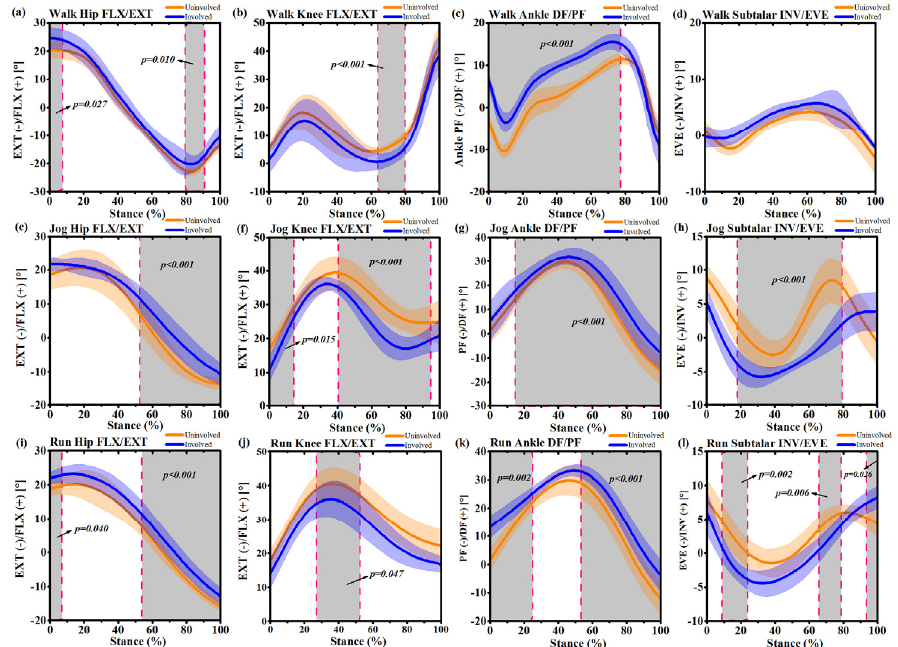
Figure 4. Mean and standard deviation lower extremity joint angle waveforms over stance phase (100%) for the uninvolved side (yellow) and involved side (blue) during self-selected speed walking, jogging and running. ( a ): Hip joint flexion / extension (FLX / EXT) during stance phase of walking; ( b ): Knee joint flexion / extension (FLX / EXT) during stance phase of walking; ( c ) Ankle joint dorsiflexion / plantarflexion (DF / PF) during stance phase of walking; ( d ) Subtalar joint inversion / eversion (INV / EVE) during stance phase of walking; ( e ): Hip joint flexion / extension (FLX / EXT) during stance phase of jogging; ( f ): Knee joint flexion / extension (FLX / EXT) during stance phase of jogging; ( g ) Ankle joint dorsiflexion / plantarflexion (DF / PF) during stance phase of jogging; ( h ) Subtalar joint inversion / eversion (INV / EVE) during stance phase of jogging; ( i ): Hip joint flexion / extension (FLX / EXT) during stance phase of running; ( j ): Knee joint flexion / extension (FLX / EXT) during stance phase of running; ( k ) Ankle joint dorsiflexion / plantarflexion (DF / PF) during stance phase of running ( l ) Subtalar joint inversion / eversion (INV / EVE) during stance phase of running. Grey shaded regions on graphs indicate a significant difference between the two sides ( p < 0.05) from SPM1d (one-dimensional Statistical Parametric Mapping) analyses. Table 2. The peak joint kinematics of the involved side (IS) and the uninvolved side (US) during walking, jogging and running movements.